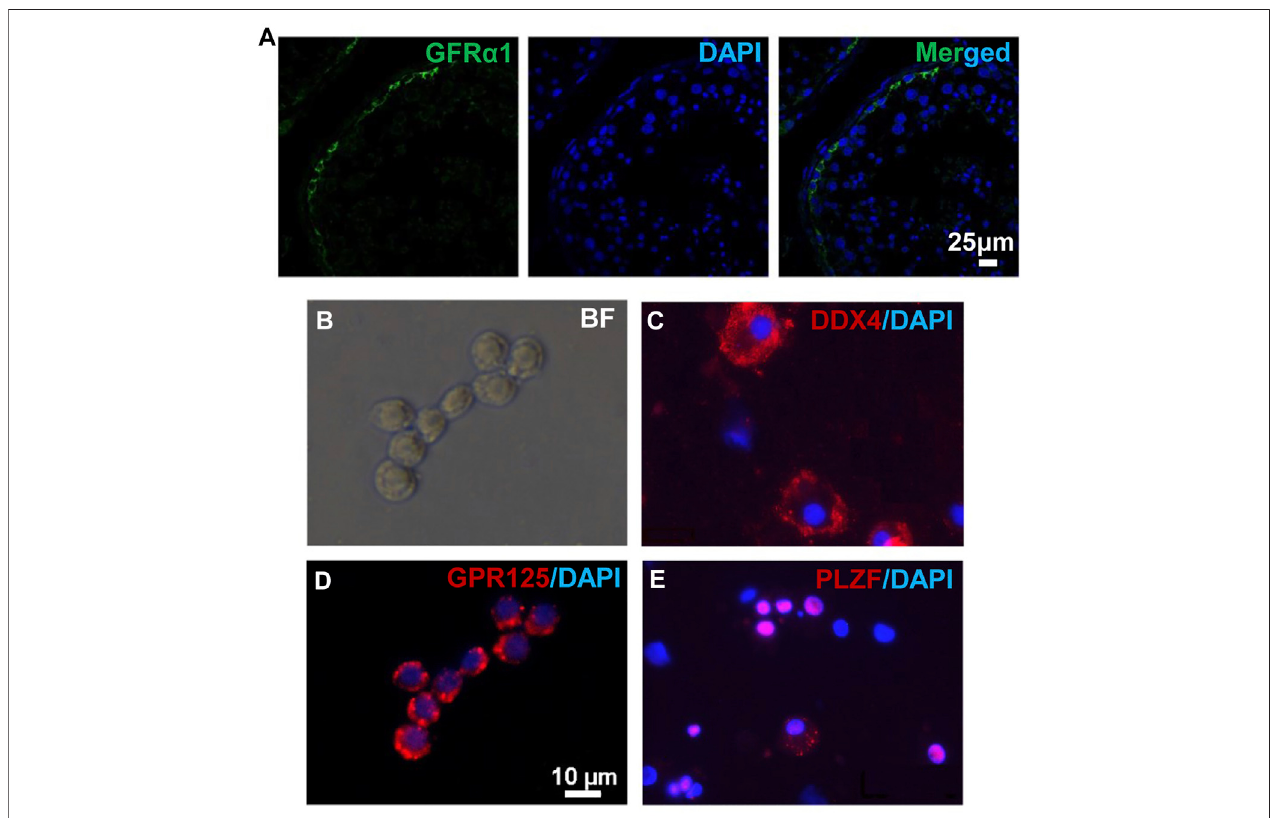
FIGURE 1 | Human germ cells were collected from biopsied testes. (A) IHF was performed on biopsied testes from OA patients with a GFR α 1 antibody. (B – E) Isolated human spermatogonia were observed in bright fi eld (B) , and detected by IF with antibodies against DDX4 (C) , GPR125 (D) , and PLZF (E) , counterstained with DAPI. Scale bar: 10 μ m (B,D) cells were cultured on a cover glass. (C,E) cells were spun onto slides by cytospin preparation.